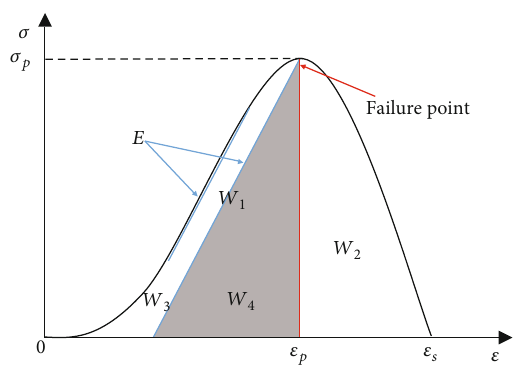
Figure 12: The energy evolution process of rock under uniaxial compression.